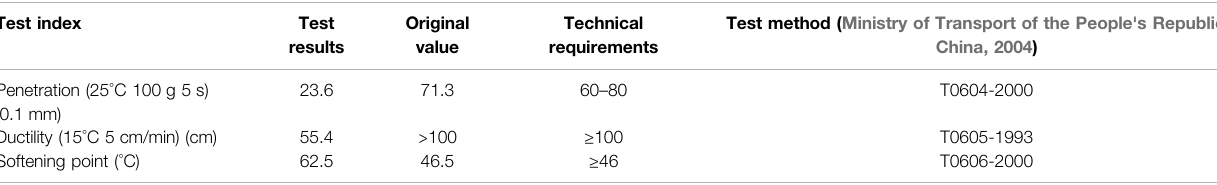
TABLE 3 | Test index of recovered 70# asphalt.